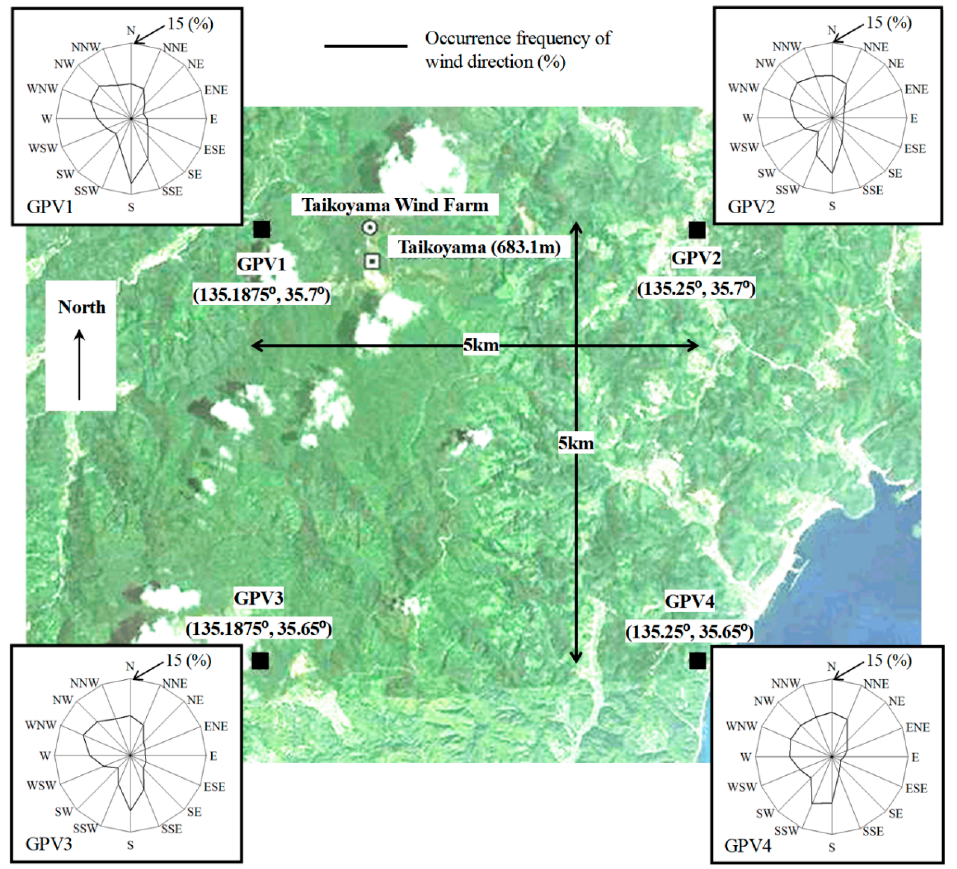
Figure 12. Wind characteristics in the vicinity of Taikoyama Wind Farm based on MSM-S GPV data for 2012.